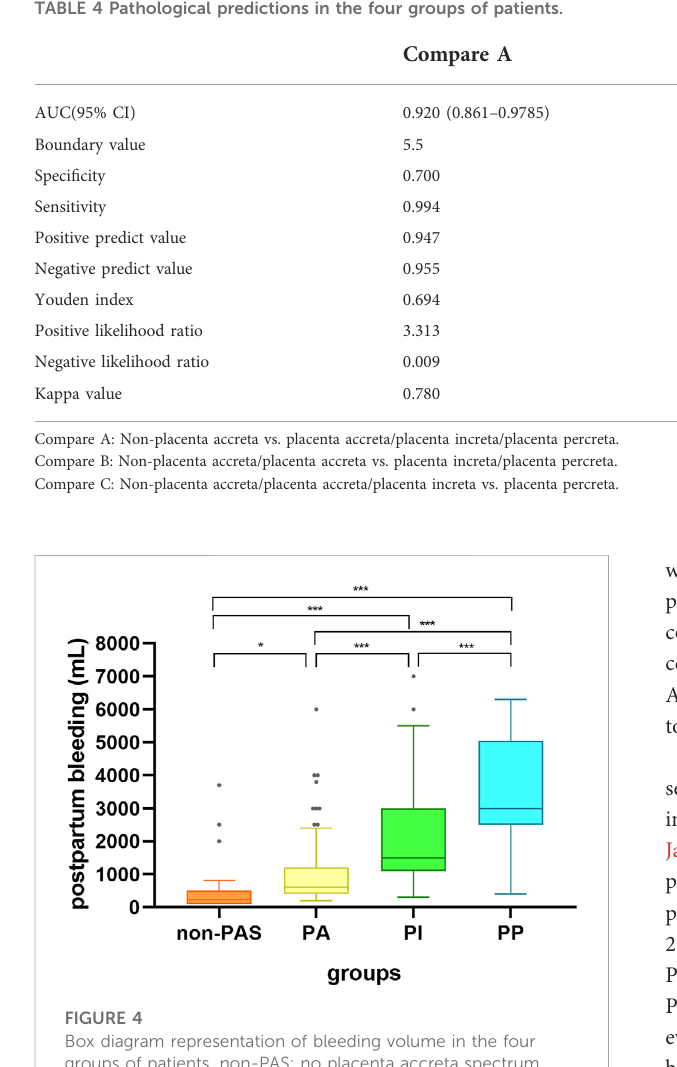
TABLE 4 Pathological predictions in the four groups of patients.